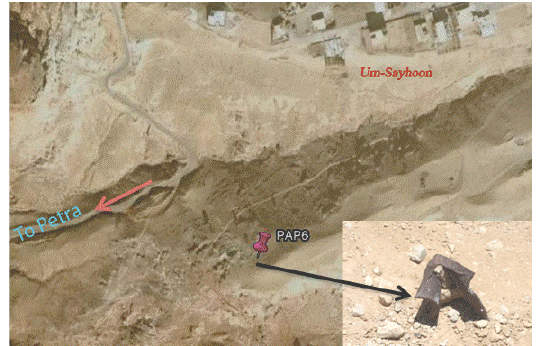
Figure 5: materialized point illustrated with a georeferenced